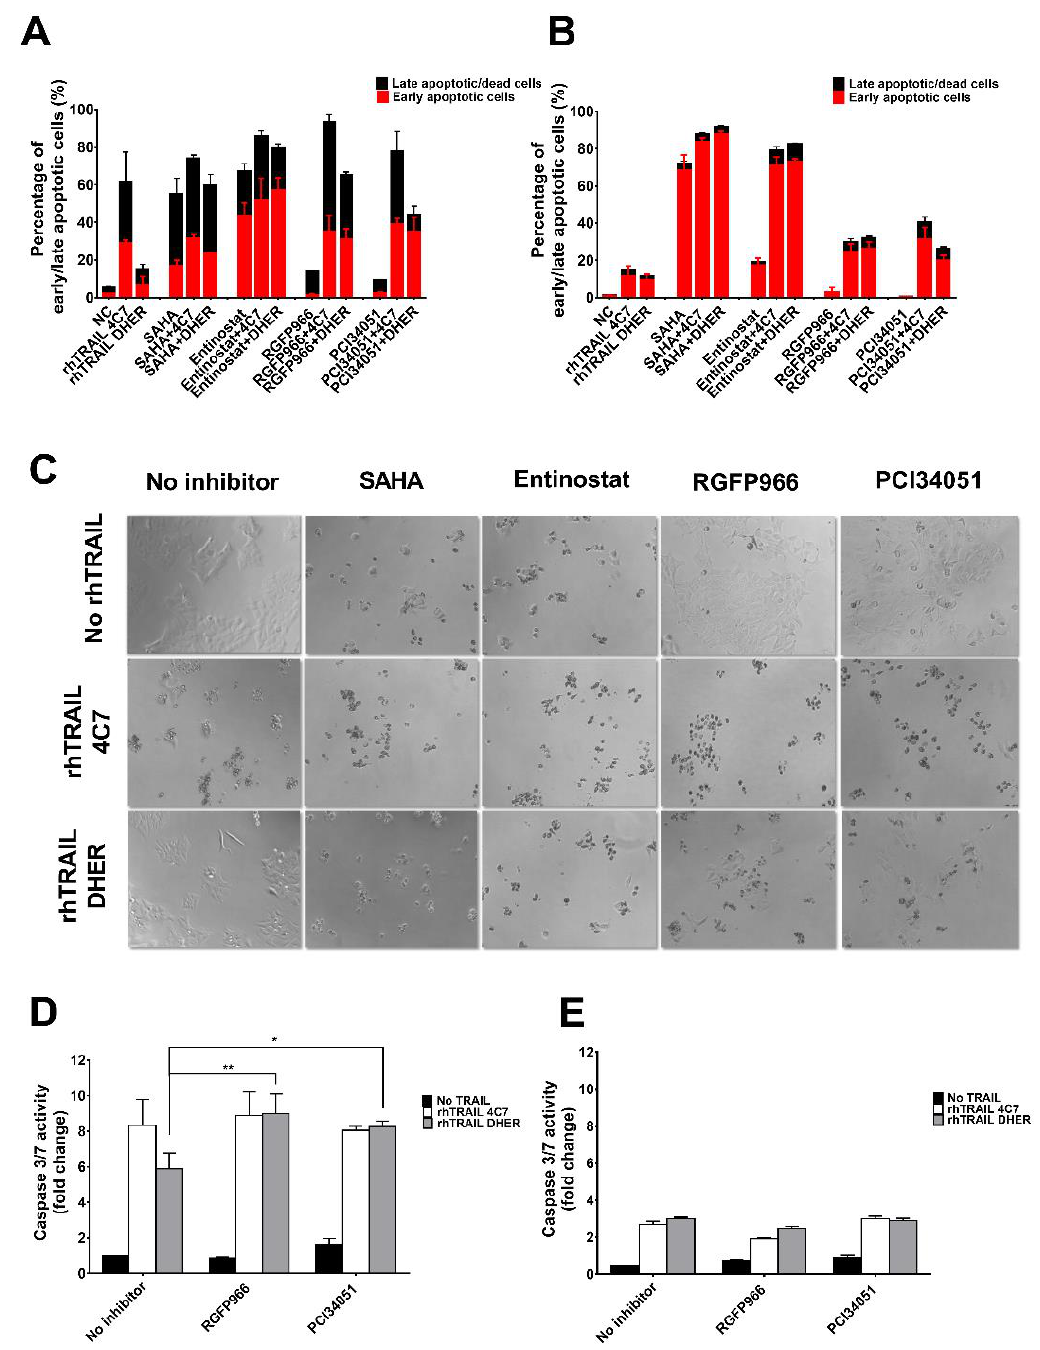
Figure 2. HDAC3-specific inhibitor RGFP966 or HDAC8-specific inhibitor PCI34051 increases TRAIL-mediated apoptosis. DLD-1 ( A ) or WiDr ( B ) cells were pre-treated with 5 µ M HDAC inhibitors for 24 h and then incubated with 25 ng / mL rhTRAIL 4C7 or DHER for overnight. Early or late apoptotic cells were detected using the Violet Ratiometric Membrane Asymmetry Probe. NC represents the cells without treatment with HDAC inhibitors or rhTRAIL variants. Statistics: Entinostat vs. Entinostat + TRAIL variants, 0.0001 ≤ p ≤ 0.001; TRAIL variants vs. Entinostat + TRAIL variants, 0.0001 ≤ p ≤ 0.001 ( C ) Morphological changes of DLD-1 cells treated with HDAC inhibitors and rhTRAIL 4C7 or DHER observed under an inverted light microscope with 20 × magnification. DLD-1 ( D ) or WiDr ( E ) cells were pre-treated by 10 µ M RGFP966 or PCI34051 for 24 h and stimulated with 25 ng / mL rhTRAIL 4C7 or DHER overnight. Caspase 3 / 7 activity was measured after 2 h incubation. The values shown are mean ± SD from one of three experiments performed in triplicate. p values